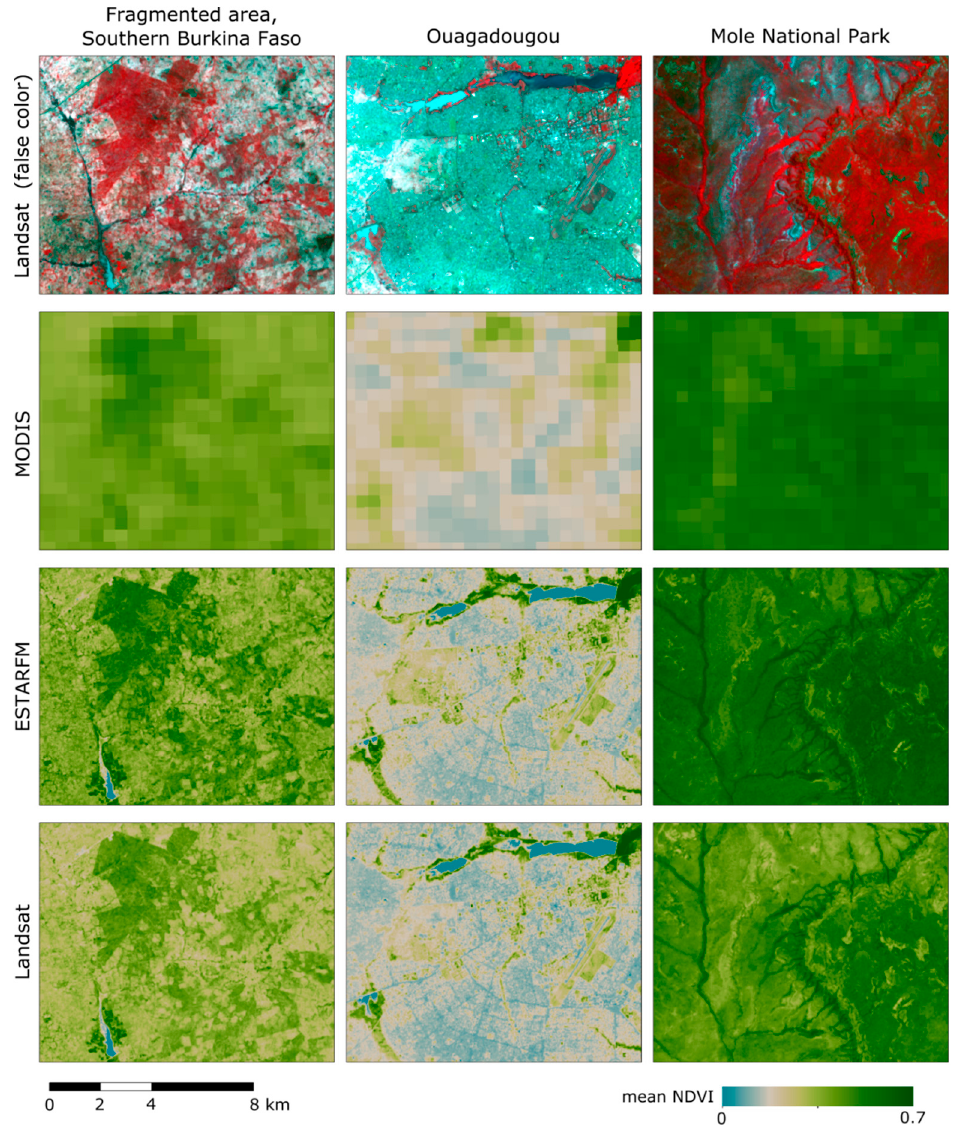
Figure 7. Landsat false color composite (NIR-R-G, row 1 ), mean annual NDVI (year 2014) derived from MODIS ( row 2 ), ESTARFM ( row 3 ) and Landsat ( row 4 ) for three focus areas: a fragmented landscape area in the south of Burkina Faso ( left column ), the city of Ouagadougou in Burkina Faso ( middle column ) and the Mole National Park in Ghana ( right column ).